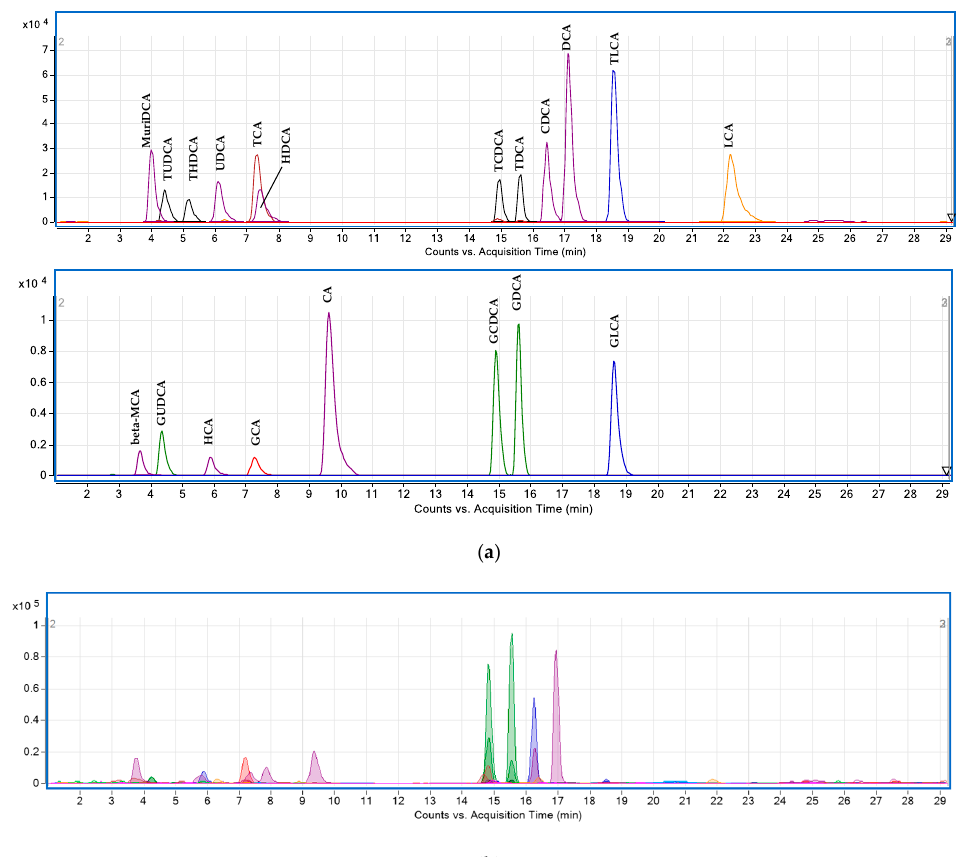
Figure 3. MRM chromatograms using UHPLC-QQQ: ( a ) BA standards in blank plasma; ( b ) BA compounds in human plasma. Abbreviations: cholic acid (CA), chenodeoxycholic acid (CDCA), deoxycholic acid (DCA), glycocholic acid (GCA), glycochenodeoxycholic acid (GCDCA), glycodeoxycholic acid (GDCA), glycolithocholic acid (GLCA), glycoursodeoxy- cholic acid (GUDCA), hyocholic acid (HCA), hyodeoxycholic acid (HDCA), lithocholic acid (LCA), β -muricholic acid ( β -MCA), murideoxycholic acid (MuriDCA), taurocholic acid (TCA), taurochenodeoxycholic acid (TCDCA), taurodeoxy- cholic acid (TDCA), taurolithochoic acid (TLCA), tauroursodeoxycholic acid (TUDCA), taurohyodeoxycholic acid (THDCA), ursodeoxycholic acid